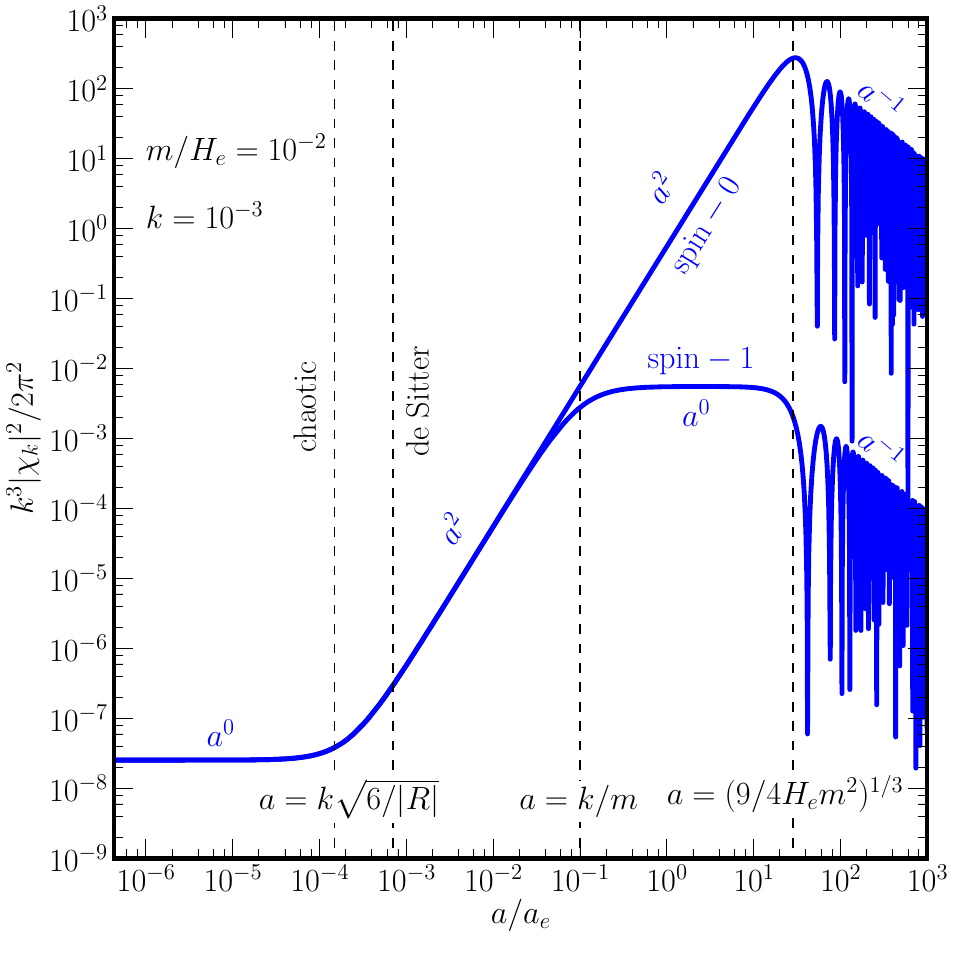
Figure 2 . Numerical results for the evolution of k 3 | χ k | 2 / 2 π 2 for m/H e = 10 − 2 and k = 10 − 4 . Shown are the results for the longitudinal component of a massive vector field (“spin-1”) and for comparison the evolution of a massive minimally-coupled scalar field (“spin-0”), which corresponds to the transverse component. The left-most pair of vertical dashed lines corresponds approximately to the time when this mode left the horizon during inflation (assuming either chaotic m 2 φ 2 inflaton, or simply de Sitter). The dashed line labeled a = k/m corresponds to the time when this mode became nonrelativistic. Inflation ends at a/a e = 1 . The right-most dashed line corresponds to the time when H ( a ) ≈ m